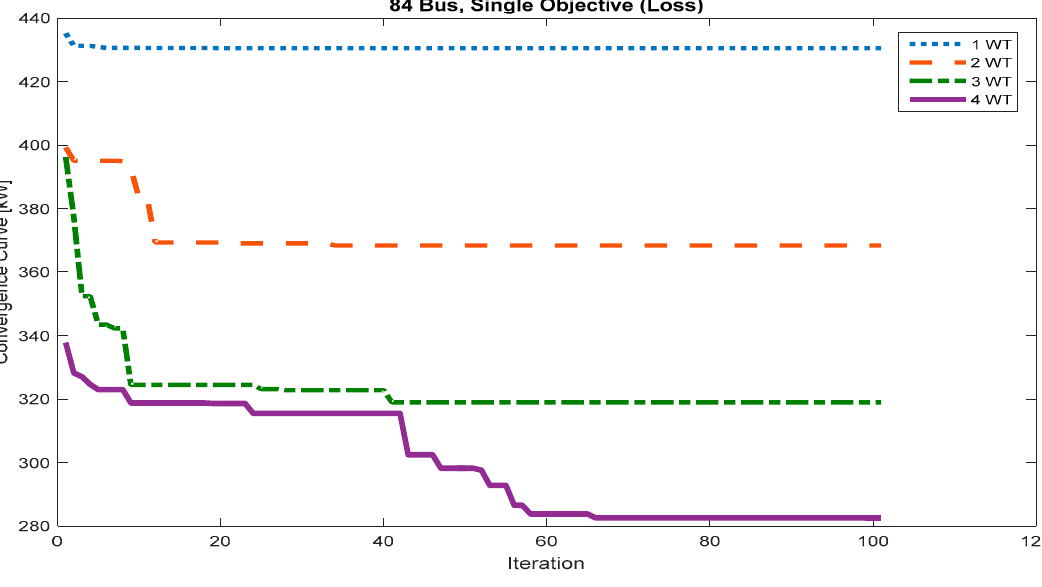
Figure 3. Convergence curve of the PSO method in the optimal site selection of turbines without considering constraints (single-objective). Table 1. This Results of optimal turbine site selection without considering constraints